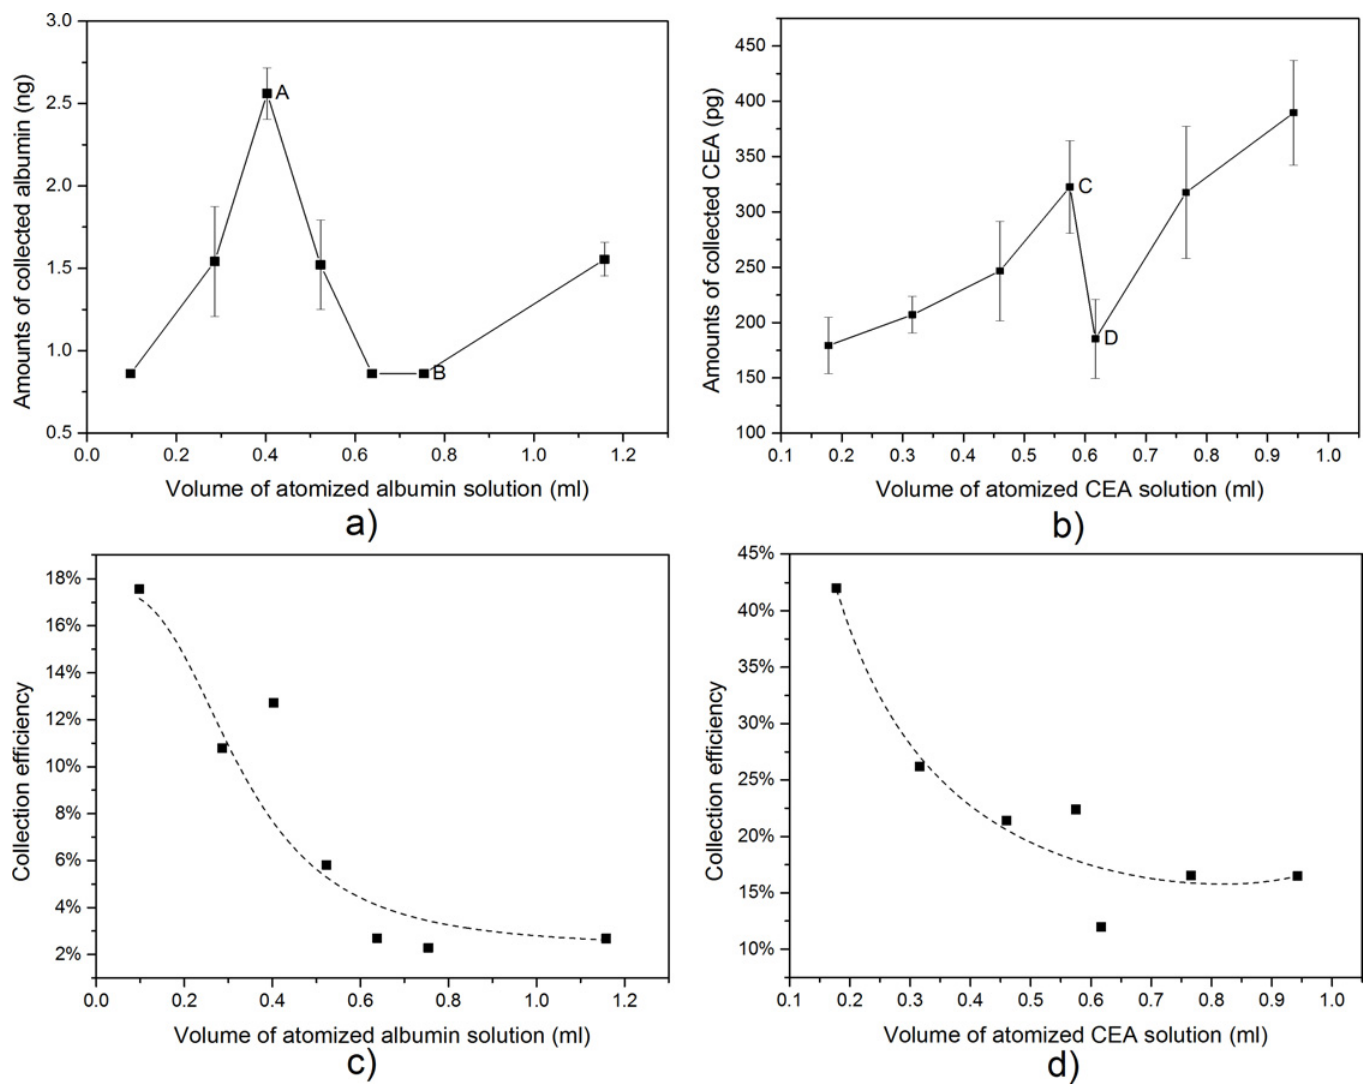
Fig 4. Collecting ability of electret filters in collecting atomized protein particles. (a) Amounts of collected albumin when the volume of atomized albumin solution increased. Amounts of collected albumin increased as the volume of atomized albumin solution increased before point A, then decreased, and finally increased again after point B. (b) Amounts of collected CEA when the volume of atomized CEA solution increased. Amounts of collected CEA increased as the volume of atomized CEA solution increased before point C, then decreased, and finally increased again after point D. (c) Mean collecting efficiency of electret filters when the volume of atomized albumin solution increased. (d) Mean collecting efficiency of electret filters when the volume of atomized CEA solution increased. Amounts of collected proteins were calculated by Eq 2. Collecting efficiencies were calculated by Eq 3. Error bars shown in a) and b) were standard deviation of triplicate